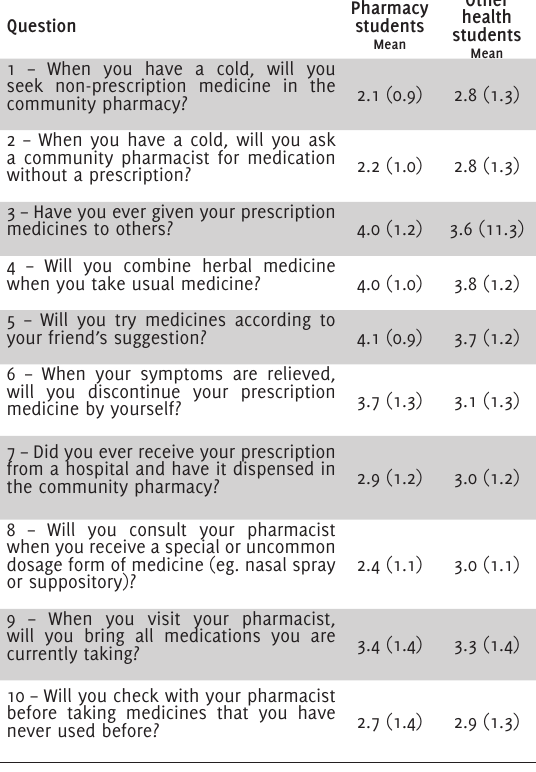
Table 4. Medication use or practice among pharmacy and other health co- llege